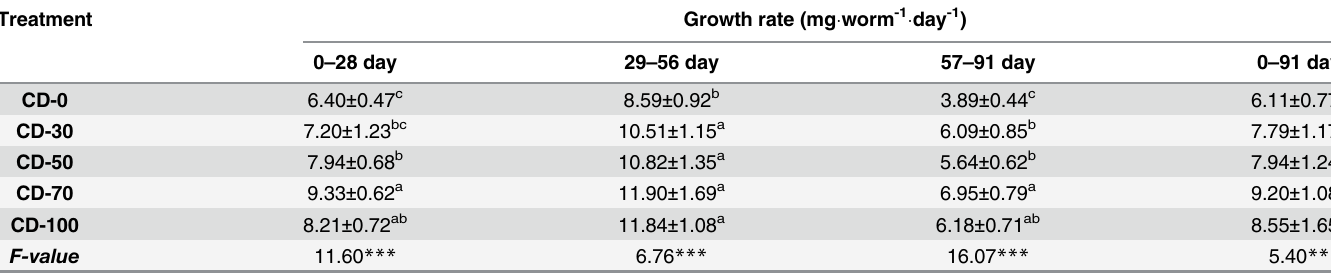
Table 3. The growth rate of Eisenia fetida among the all treatments (mg (cid:1) worm -1 (cid:1) day -1 ).